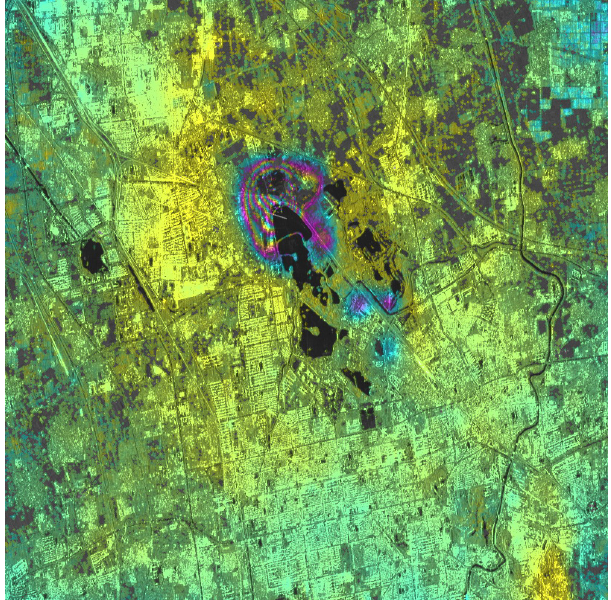
Figure 4. Deformation velocity of the Nanhu mining area. (The bottom gray image is sentinel-1 radar image and superimposed color fringe presents deformation velocity, one color cycle repre- sents 10cm per